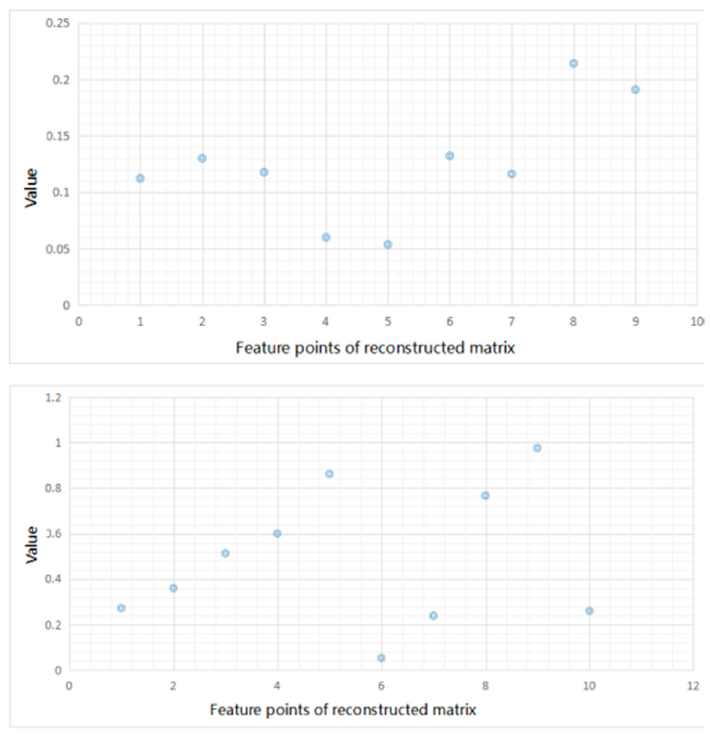
Figure 7. Input feature matrix and reconstructed matrix of one sample.